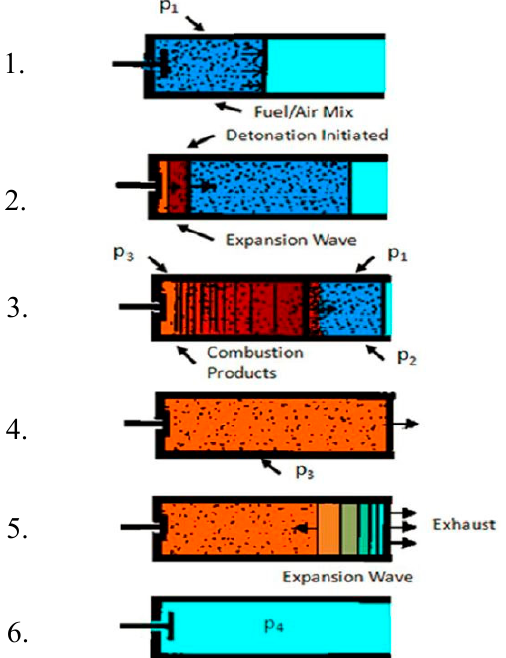
Figure 1. Detonation process adapted from Blanco [38], with permission from Cranfield University, 2014.